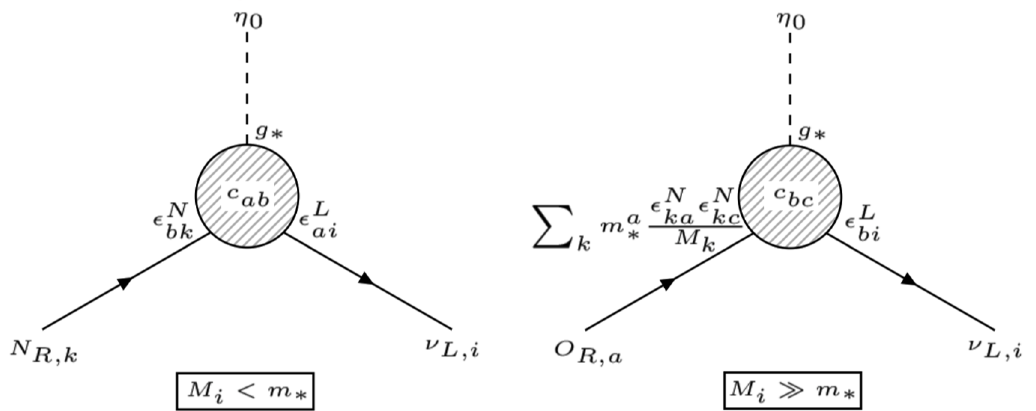
Figure 12 . Diagrams for the PC approach showing how Yukawa couplings with the neutrinos and η 0 are formed for M i < m ∗ and M i (cid:29) m ∗ ,